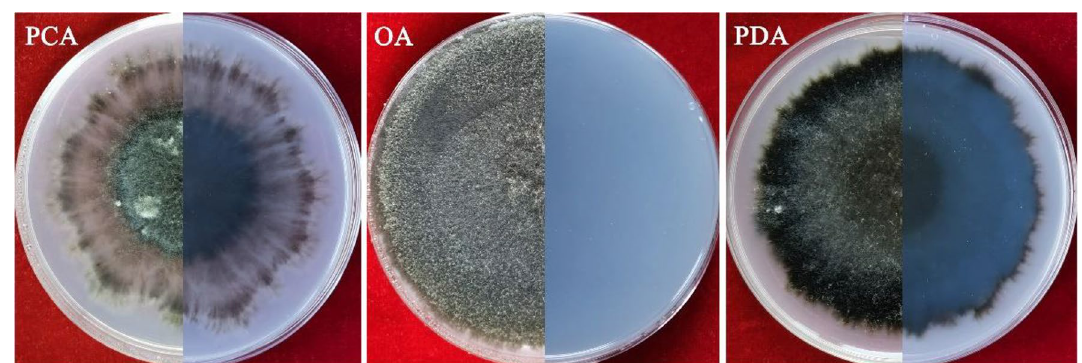
Figure 2. The colony of B. exigua cultured in the PCA, OA, and PDA.